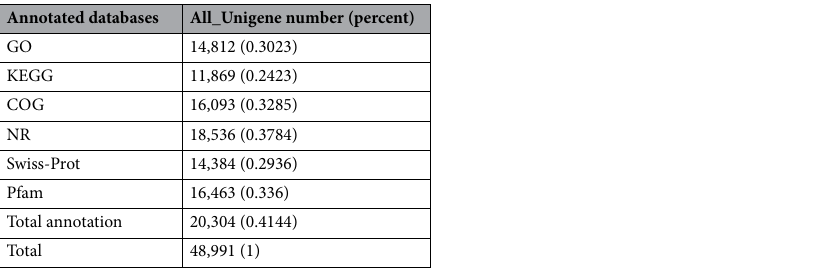
Table 3. Annotation percentages of unigenes in different databases. GO Gene Ontology, NR, KEGG Kyoto Encyclopedia of Genes and Genomes, COG clusters of orthologous groups of proteins, NCBI non-redundant protein